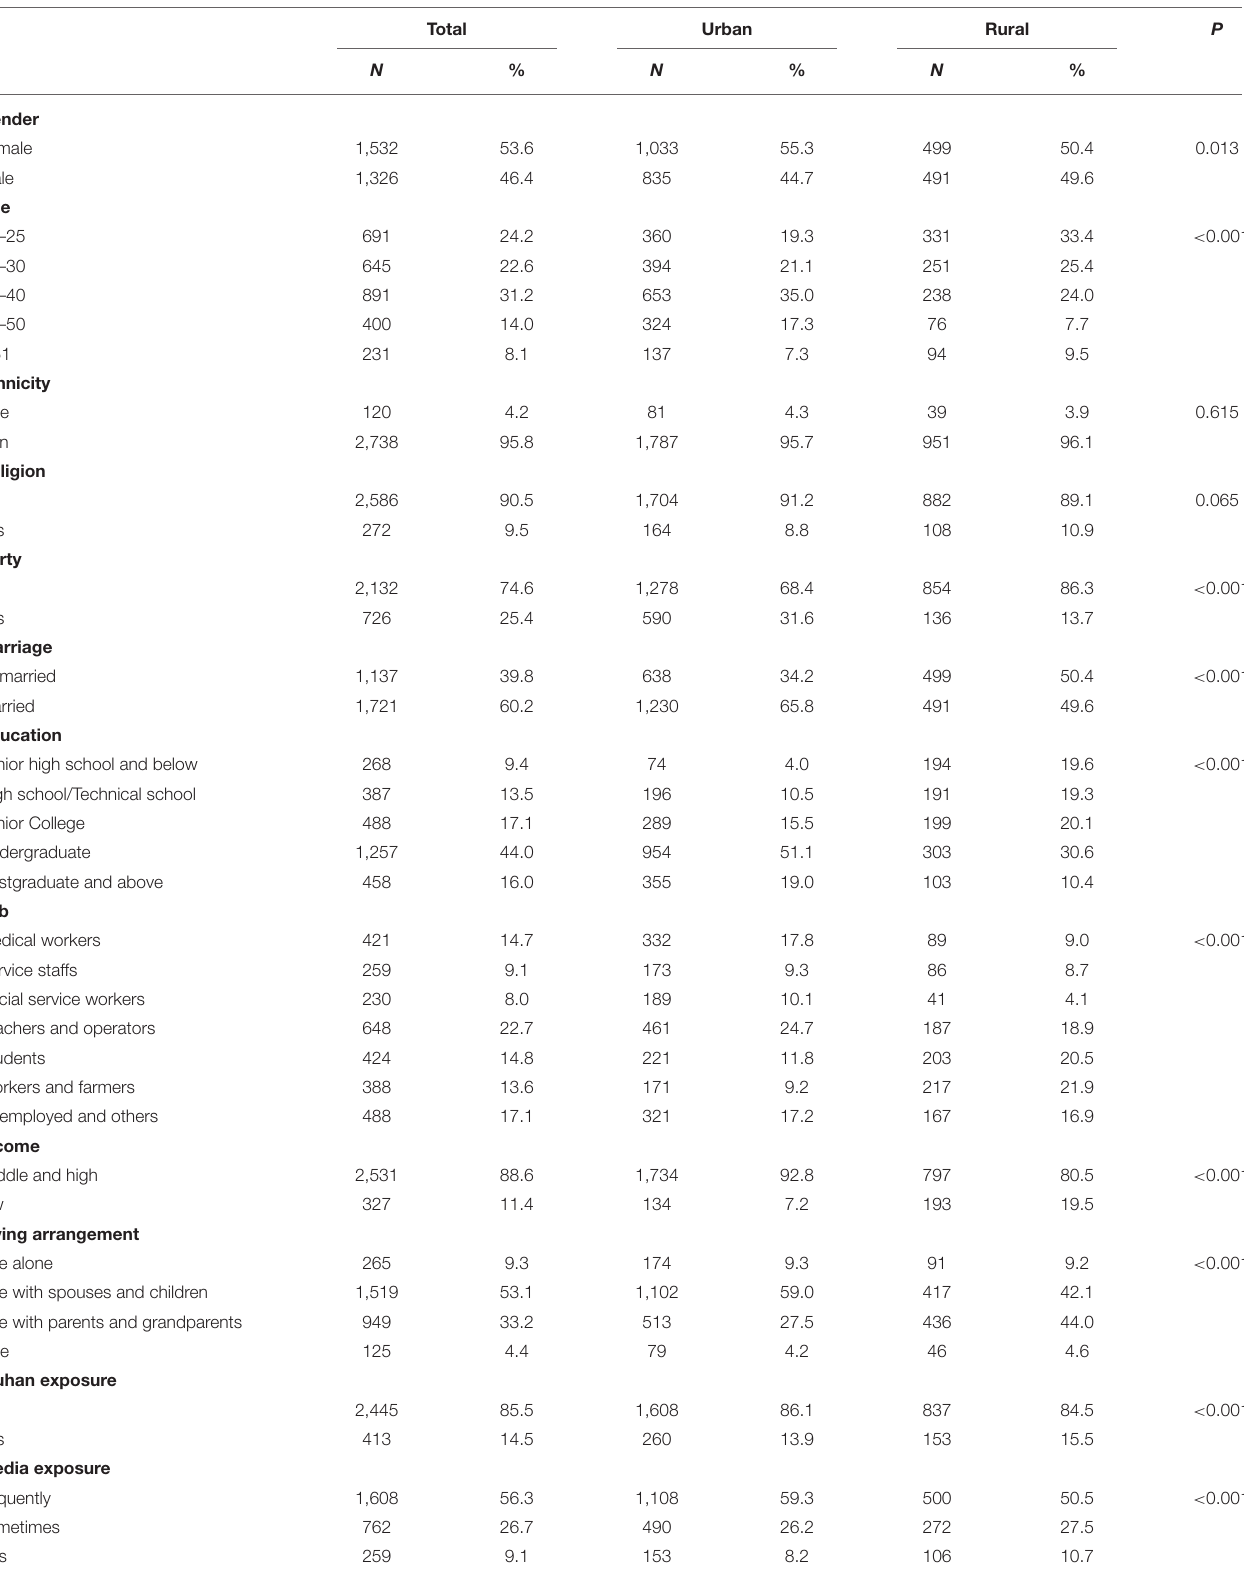
TABLE 1 | Descriptive statistics of sample